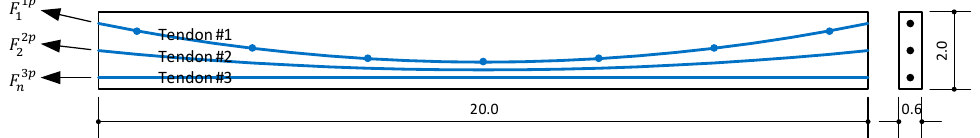
Figure 4. Example PSC girder for the verification of the proposed method (unit: m).